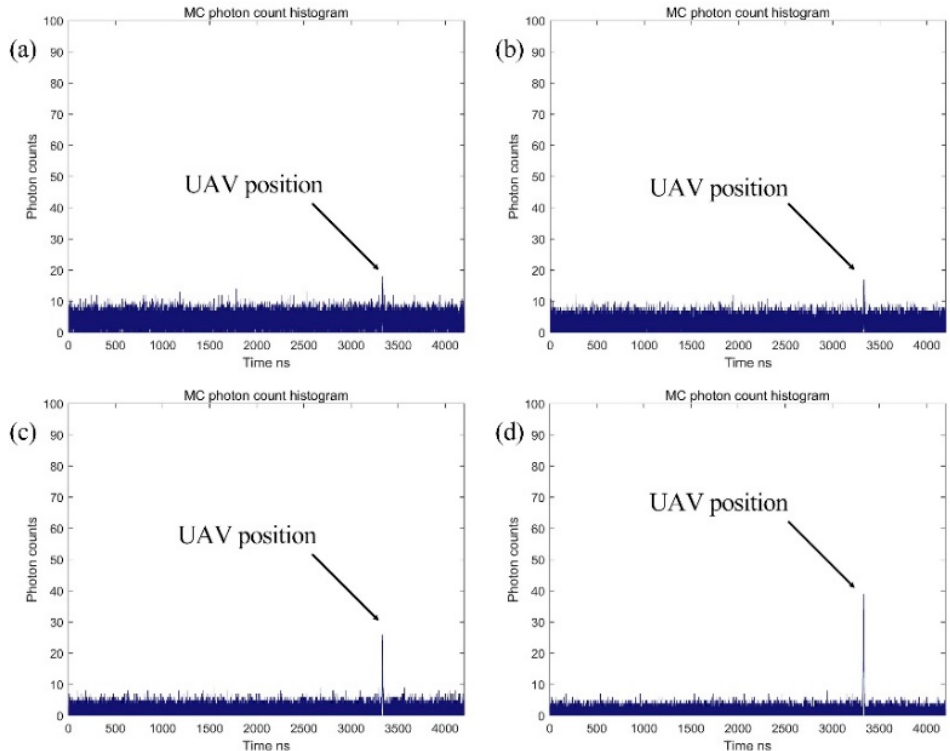
Figure 5. Photon echoes in different fields of view ( a ) 40 mrad, ( b ) 30 mrad, ( c ) 25 mrad, and ( d ) 20 mrad under nighttime conditions.